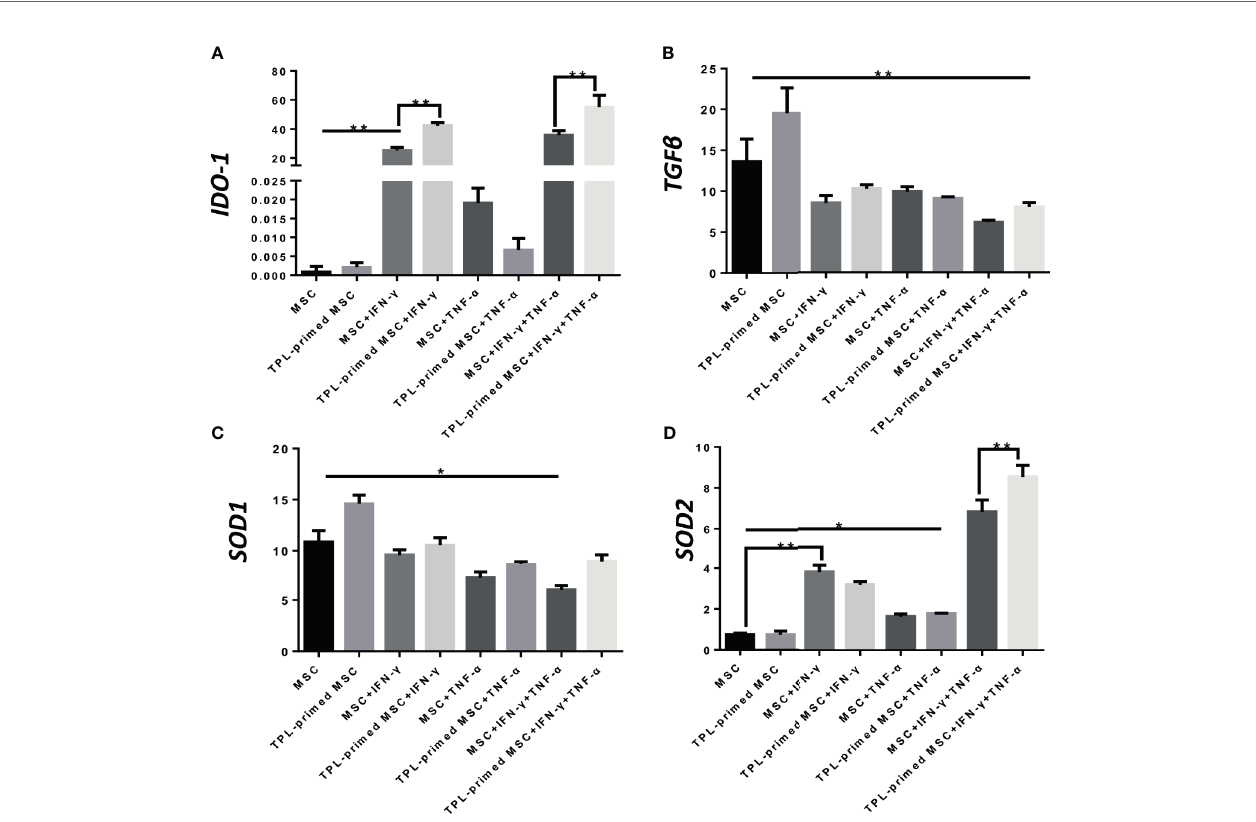
FIGURE 4 | Gene expression of suppressive molecules in TPL-primed or non-primed UC-MSCs in the presence of IFN- g and/or TNF- a . The expression levels of IDO-1, TGF- b , SOD1, and SOD2 (A-D) in TPL-primed UC-MSCs with IFN- g /TNF- a were examined by RT-PCR. Quantitative data have been presented as the mean value of three different samples ± SD with *p < 0.05, **p <